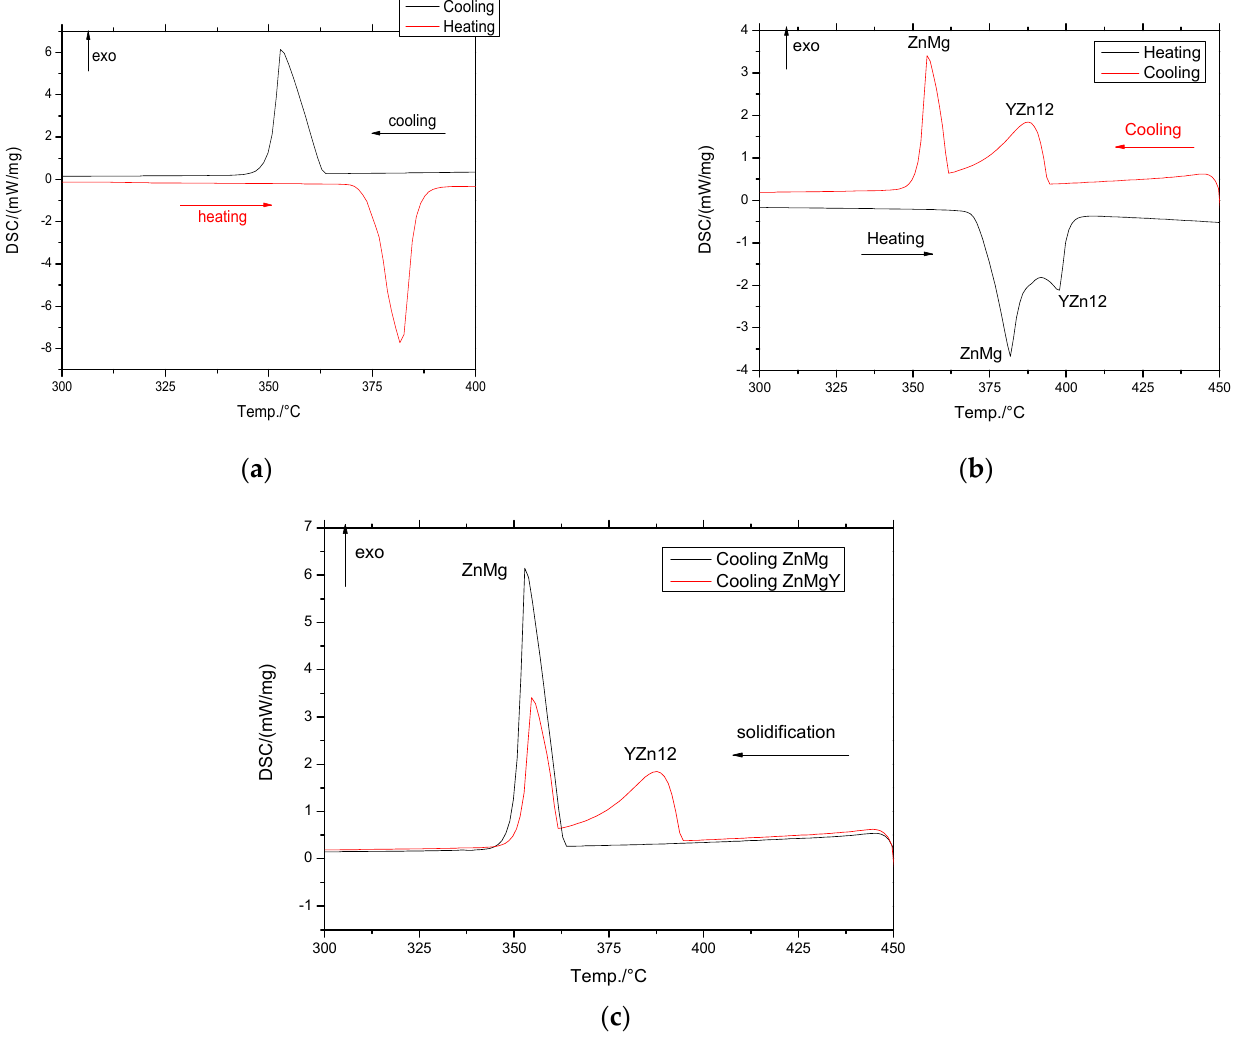
Figure 1. DSC curves of Zn3Mg and Zn3Mg0.4Y alloy: ( a ) melting and solidification of Zn3Mg alloy; ( b ) melting and solidification of Zn3MgY alloy; ( c ) solidification comparison of ZnMg with ZnMgY alloy. Table 2. DSC results of Zn, ZnMg, and ZnMgY (different Y percentages: V: 1.0; IV: 0.8; III: 0.6; II: 0.4; I: 0.2 wt%Y)